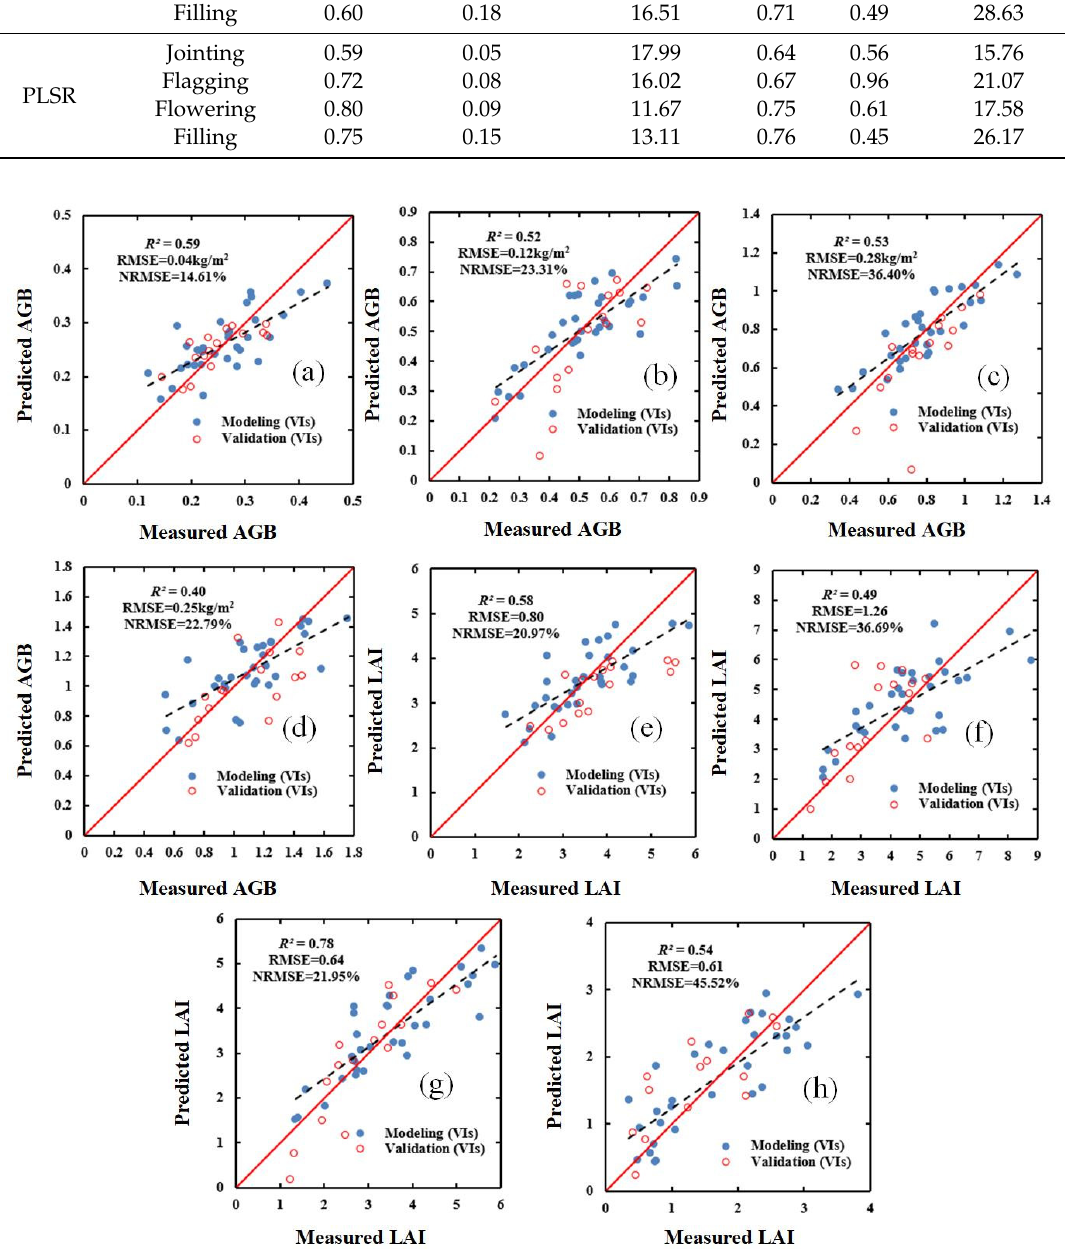
Figure 3. Relationship between ground-measured values of AGB (kg / m 2 ) and LAI (m 2 / m 2 ) in different growth stages of winter wheat and the values predicted based on vegetation indices (VIs) and stepwise regression (SWR): ( a ) AGB (jointing stage); ( b ) AGB (flagging stage); ( c ) AGB (flowering stage); ( d ) AGB (filling stage); ( e ) LAI (jointing stage); ( f ) LAI (flagging stage); ( g ) LAI (flowering stage); and ( h ) LAI (filling stage). R 2 : coefficient of determination; RMSE: root-mean-square error; NRMSE: normalized RMSE.